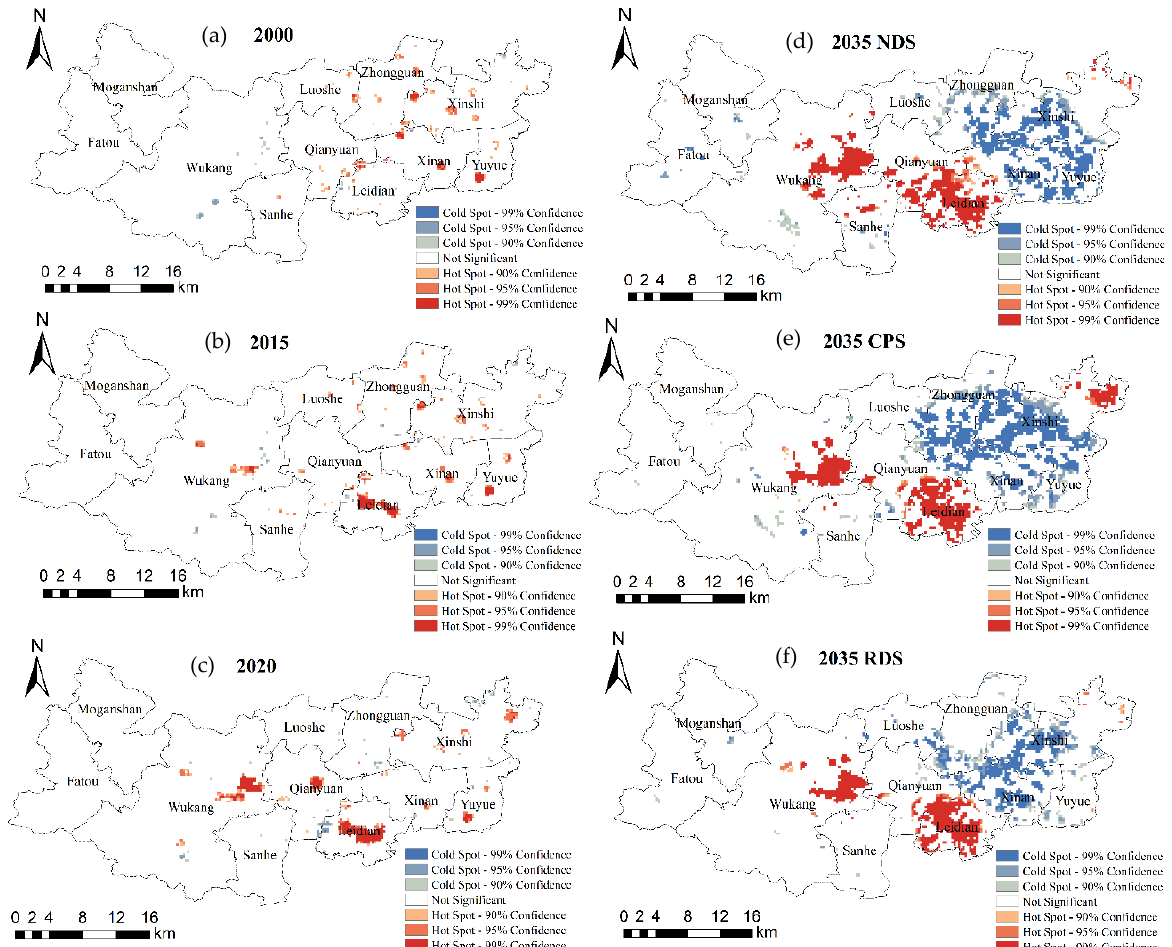
Figure 8. “Hot–cold spot” map showing the size of rural settlements during 2000–2035 (NDS, CPS, and RDS).